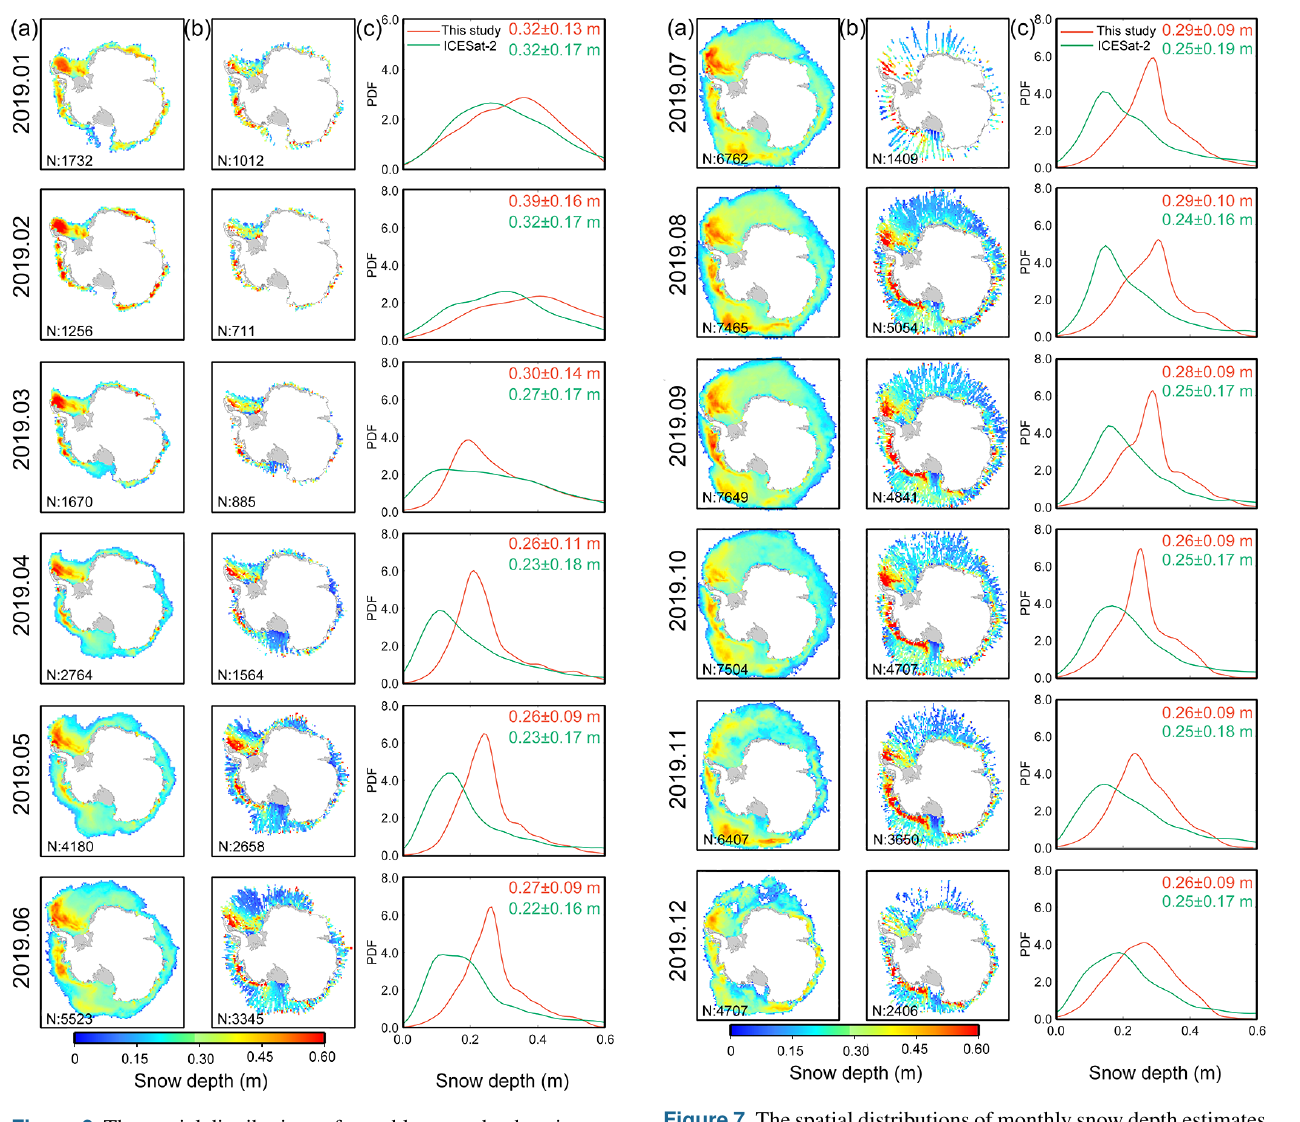
Figure 6. The spatial distributions of monthly snow depth estimates (January to June 2019) from this study (a) and ICESat-2 (b) together with the number ( N ) of valid grid cells in the bottom left corner of each image. (c) The probability density functions (PDFs) from (a) (red) and (b) (green). Numerical values in the top right corner of (c) show the mean and standard deviation of the monthly snow depth estimates from (a) (red) and (b) (green).